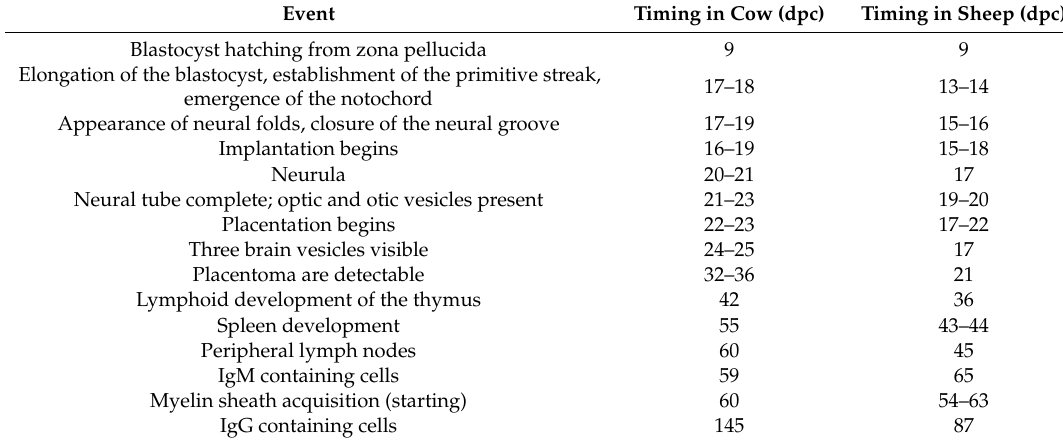
Table 2. Key events in sheep and cattle embryos / foetuses with particular emphasis on nervous and immune systems. Compiled from